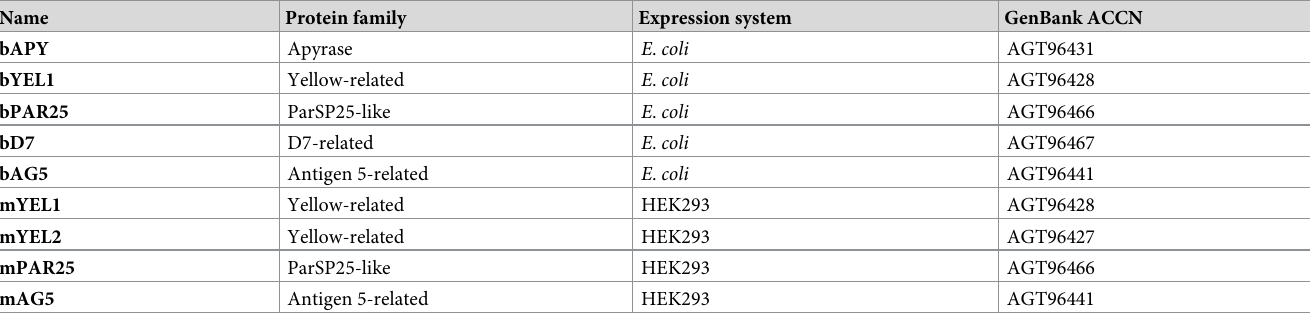
Table 1. Recombinant P . orientalis salivary proteins.